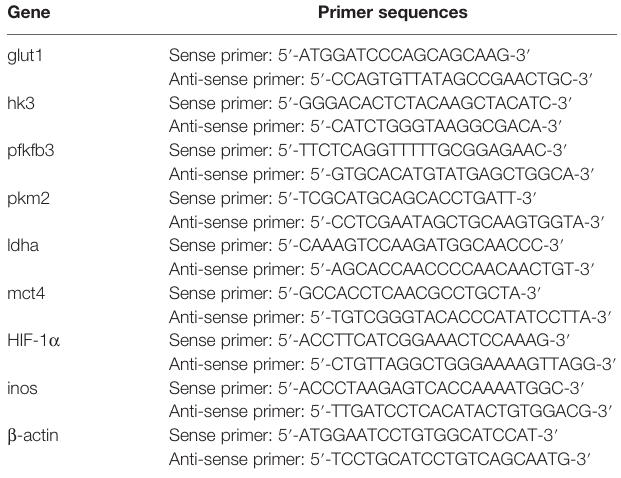
TABLE 1 | Primer sequences for ampli fi cation of mouse gene. Gene Primer